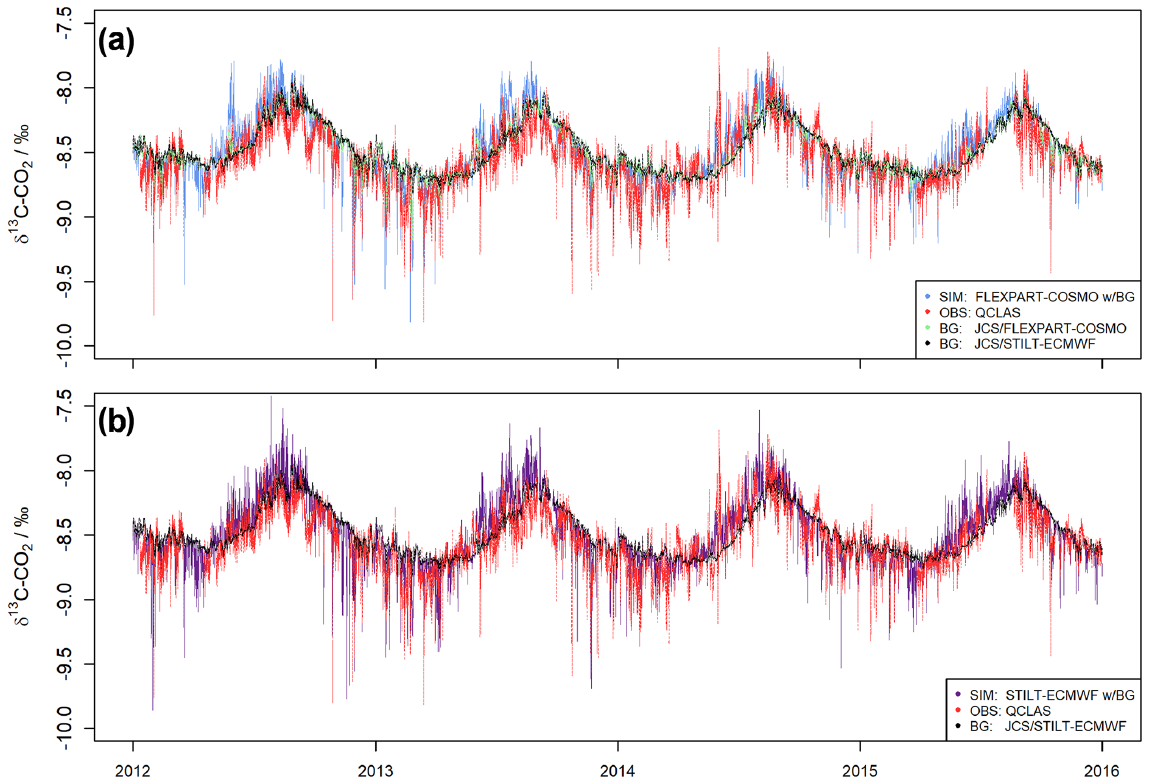
Figure 6. Time series of model-based and observed atmospheric δ 13 C–CO 2 for the years 2012–2015 (hourly observations). (a) FLEXPART– COSMO, (b) STILT-ECMWF; tick marks indicate January of each year. The background, δ 13 C b , is presented in further detail in the Supple- ment (Fig. S3b). Data are presented at hourly time resolution (zoomed versions of this figure for 2012, 2013, 2014, and 2015 are provided in the Supplement; see Figs.